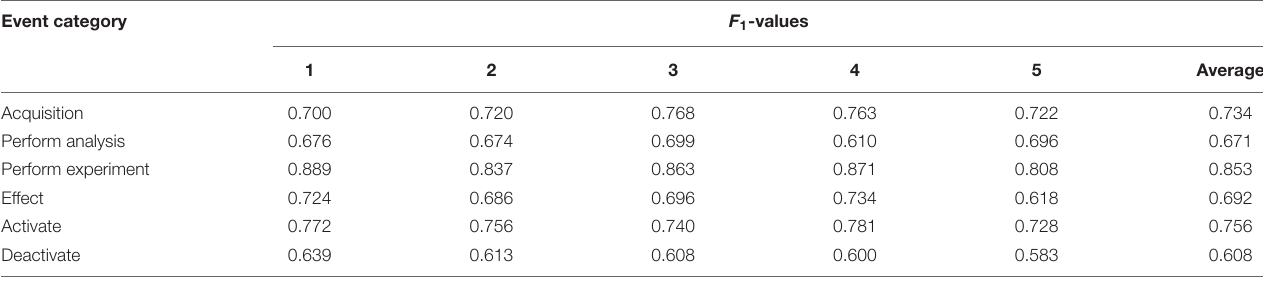
TABLE 7 | F 1 values in fivefold cross validation.